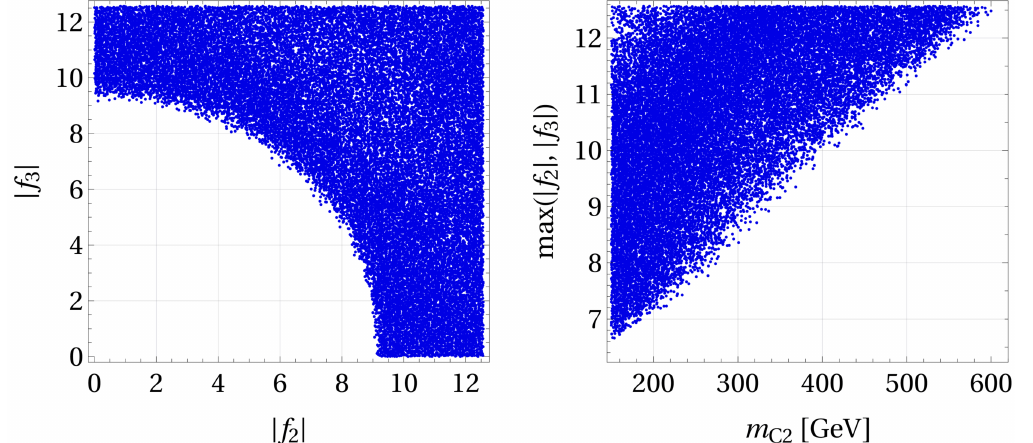
Figure 13 . Scatter plot of 3HDM points that obey the S - and T -oblique parameters constraints, fit solution 2 average at the 1 σ level, and have m 100 GeV. Left panel: the modulus of the Yukawa 3 > coupling f the modulus of f . Right panel: the largest of the two Yukawa couplings f 3 versus 2 f 3 versus the mass of the lightest charged